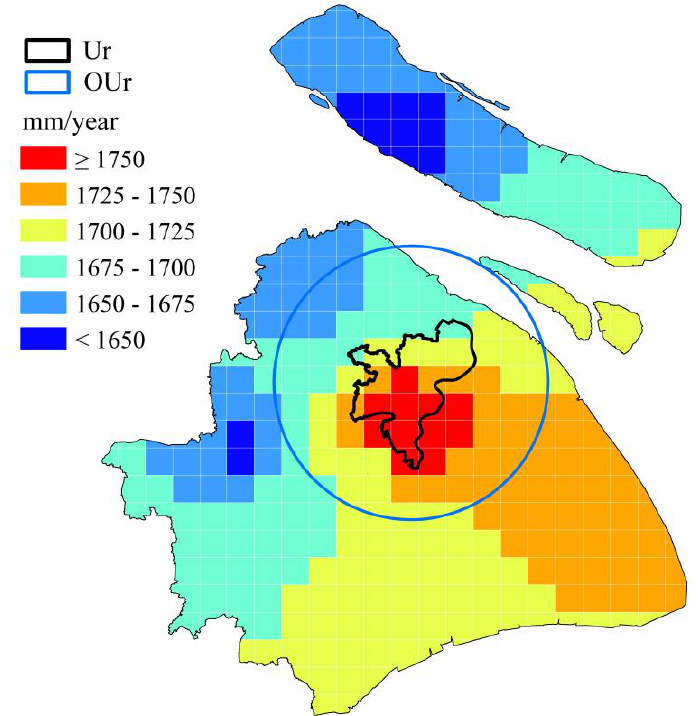
Figure 5 . Spatial distribution of the mean annual precipitation from 1979 to 2010 in Shanghai.